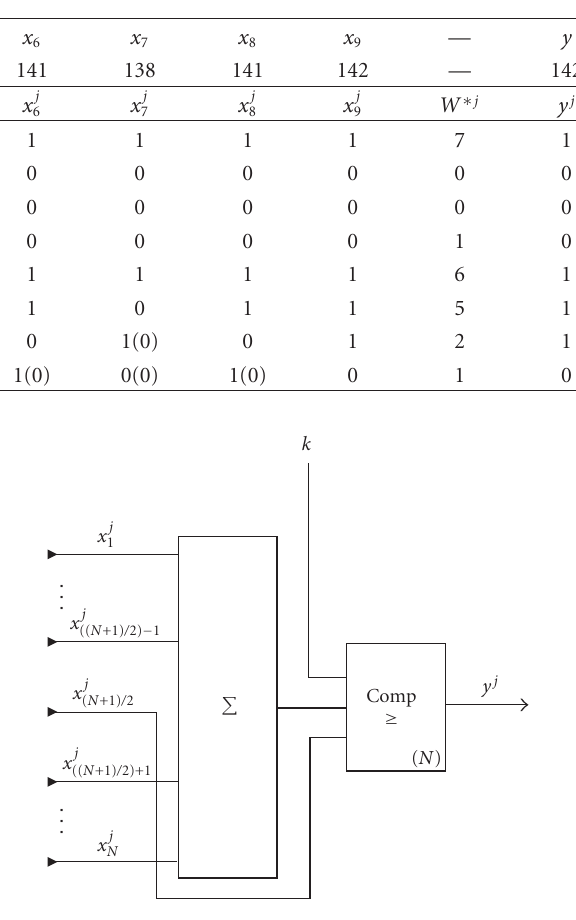
Figure 4: Internal structure of the N -input PBF function f k , N ( ·